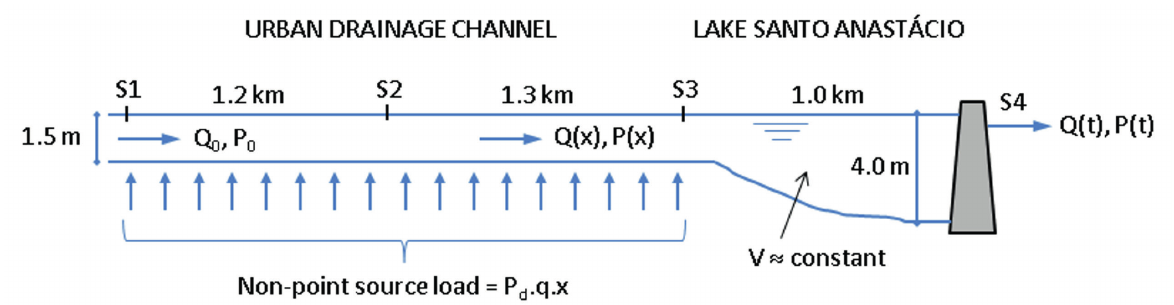
Figure 2 - Details of the urban drainage channel-shallow reservoir system. A distributed load of P from residences unconnected to the sewer system is also